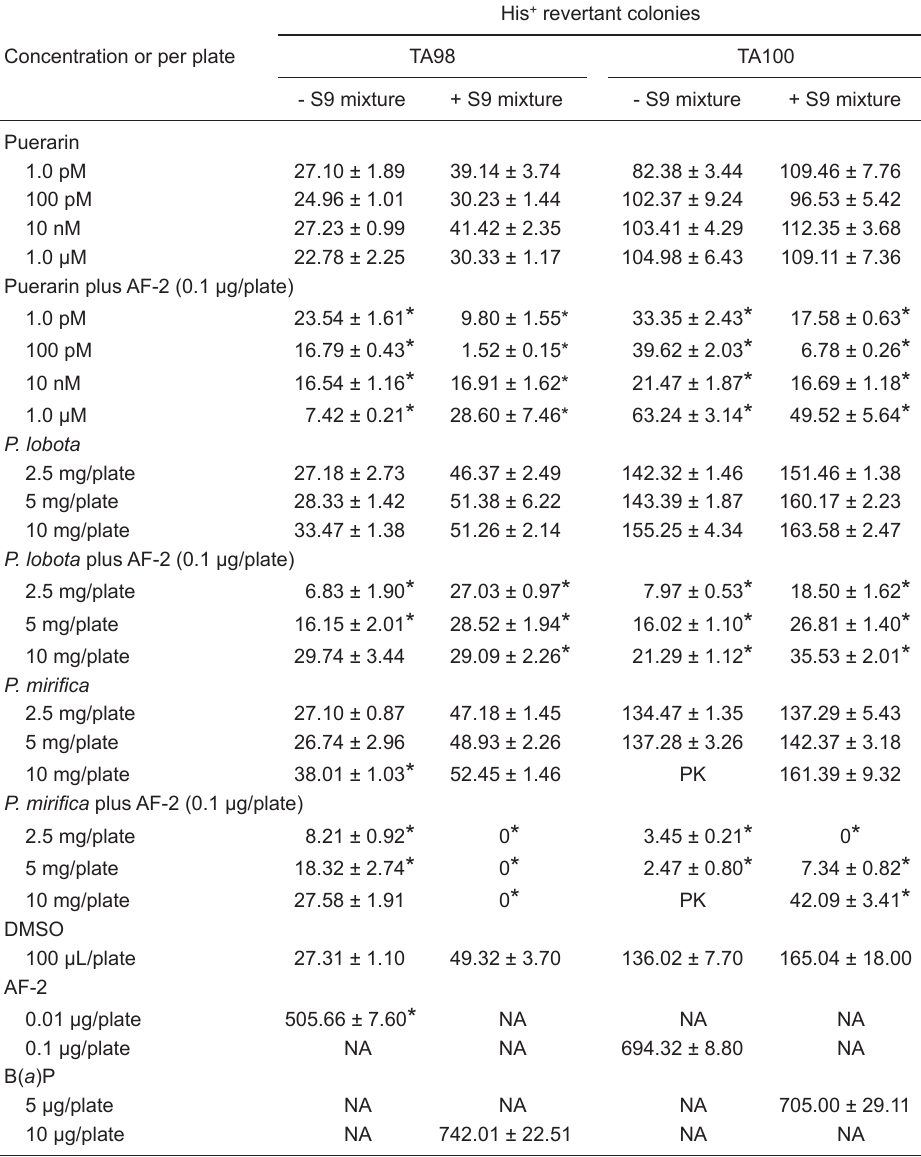
Table 2. Mutagenic and antimutagenic activity assays for Pueraria mirifica and P. lobata extracts and the isoflavonoid puerarin based on non-metabolic (without the S9 mixture) and metabolic activation (with the S9 mixture) using Salmonella typhimurium TA98 and TA100